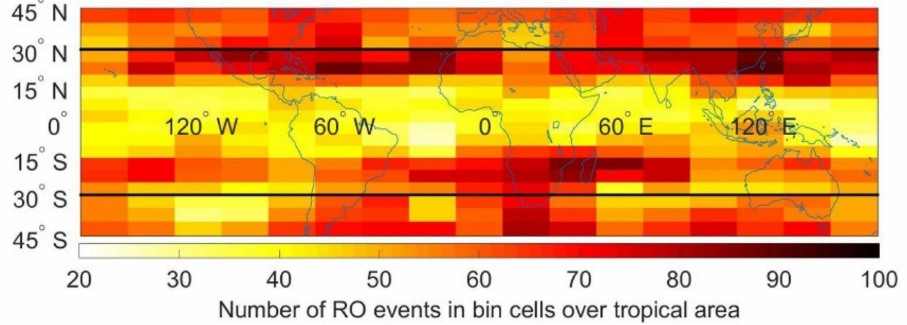
Figure 5. Number of RO events used in defined 5 ◦ latitude × 20 ◦ longitude grid cells in the tropical region on 23 January 2009 based on our defined spatial and temporal extents. The spatial extent is +/ − 5 ◦ latitude and +/ − 15 ◦ longitude, and the temporal extent is 3